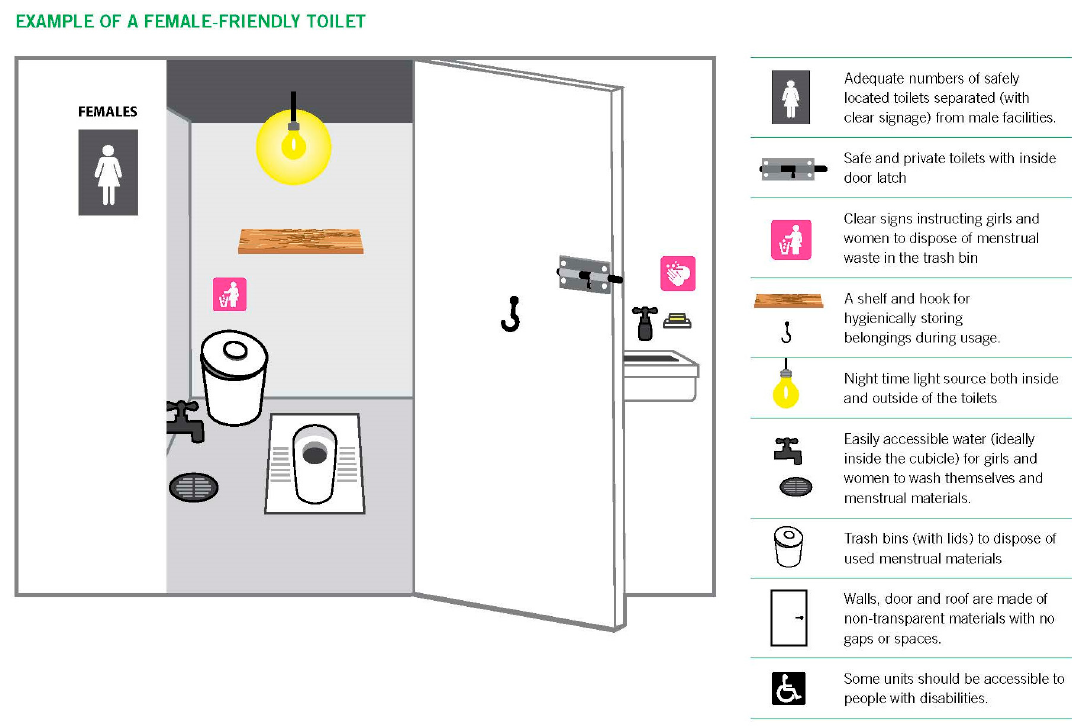
Figure 1. An example of a female-friendly toilet design for humanitarian contexts.